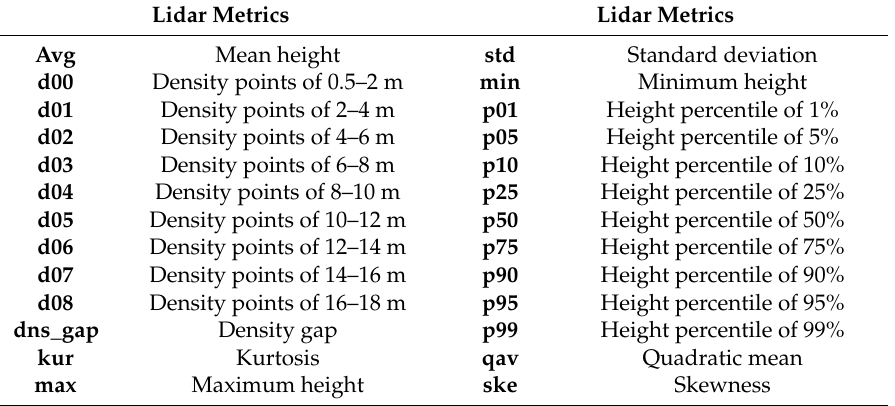
Table 3. Lidar metrics calculated from point clouds and used on predictive